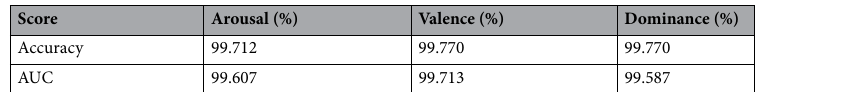
Table 6. Accuracy and AUC scores of arousal, valence and dominance of the suggested spectrogram image- based CNN-XGBoost fusion method.